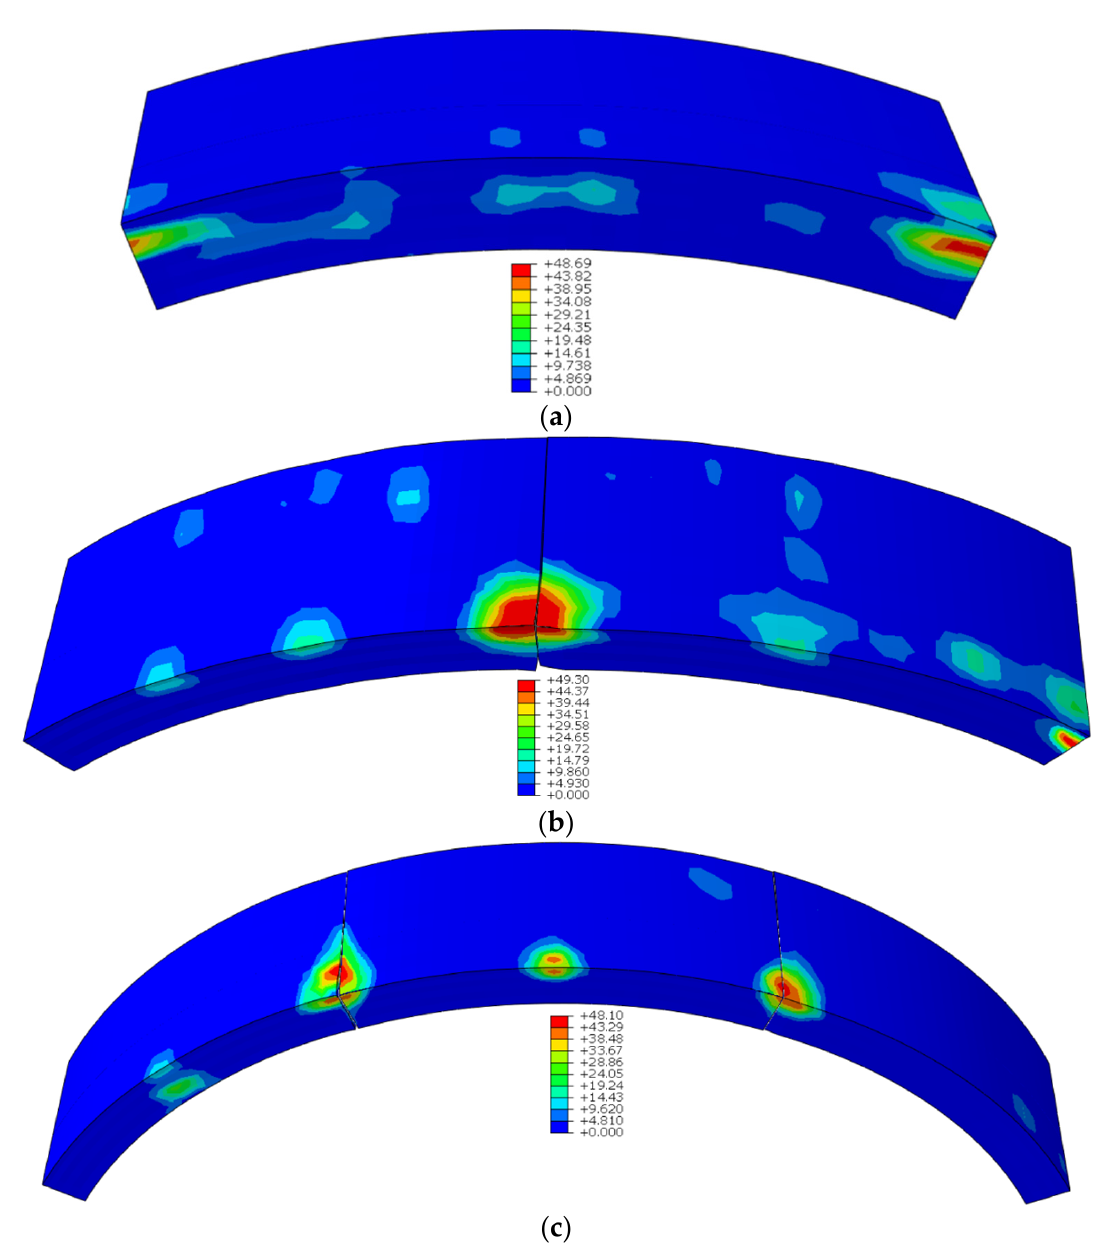
Figure 19. Damage to segment in the presence of lateral deflection when the asymmetric error angle is 2.4°: ( a ) first segment assembly (%); ( b ) second segment assembly (%); ( c ) third segment assembly (%). (Take the lateral segment as an example.)